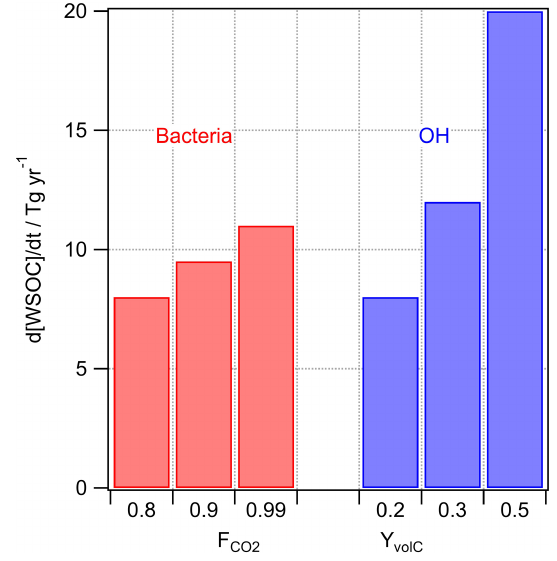
Figure 4. Predicted loss of WSOC by bacterial utilization and by chemical (OH) processing in cloud water for different assumptions on F CO and Y volC 2